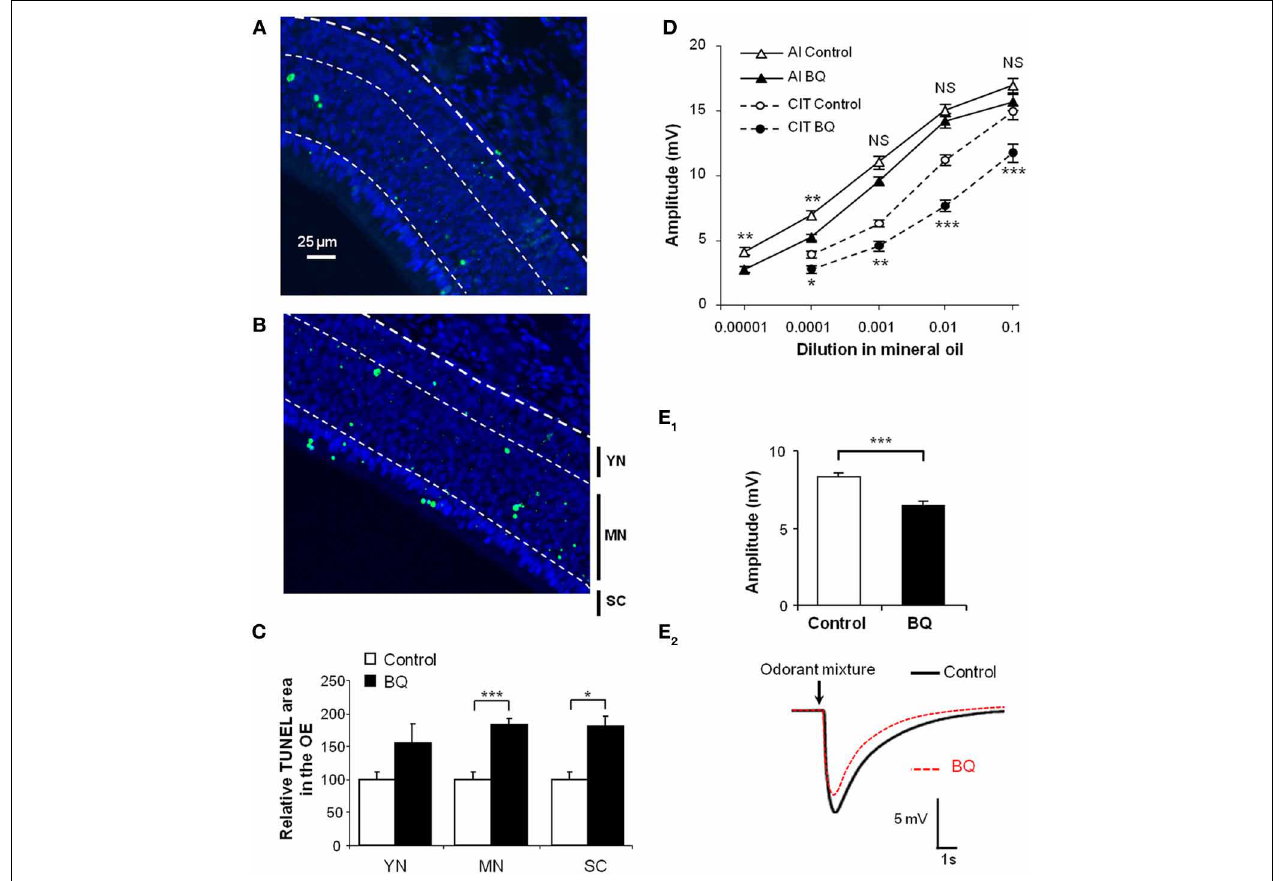
FIGURE 1 | Increase of apoptosis level in the OE and decrease of EOG responses after BQ treatment. (A,B) Representative images of TUNEL assay in the OE from 10 days old pups treated with vehicle (A) or BQ (B) . The bold dotted white line represents the basal lamina, used to delimit the area of the OE; the thin dotted white lines represent the limits of the different cell layers corresponding to basal cells and immature neurons (YN for young neurons); mature neurons (MN) and sustentacular cells (SC). The level of apoptosis was quantified as a percentage of area with TUNEL staining in each cell layer taken